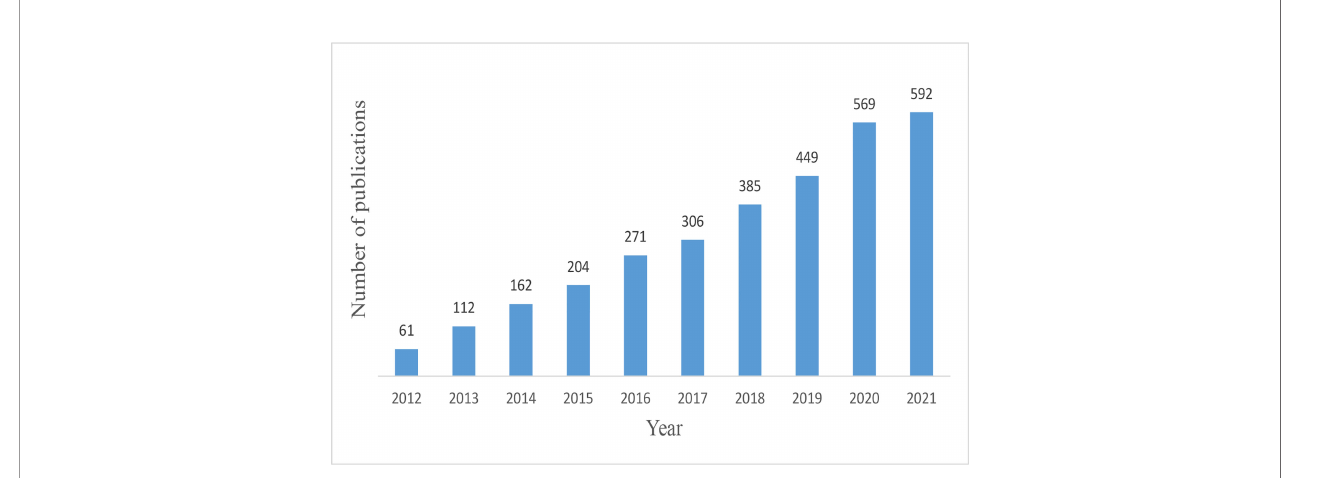
FIGURE 2 | Trends of necroptosis publications over the past